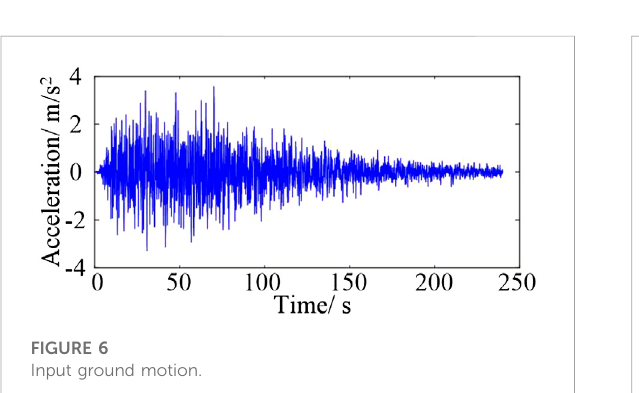
FIGURE 6 Input ground motion.